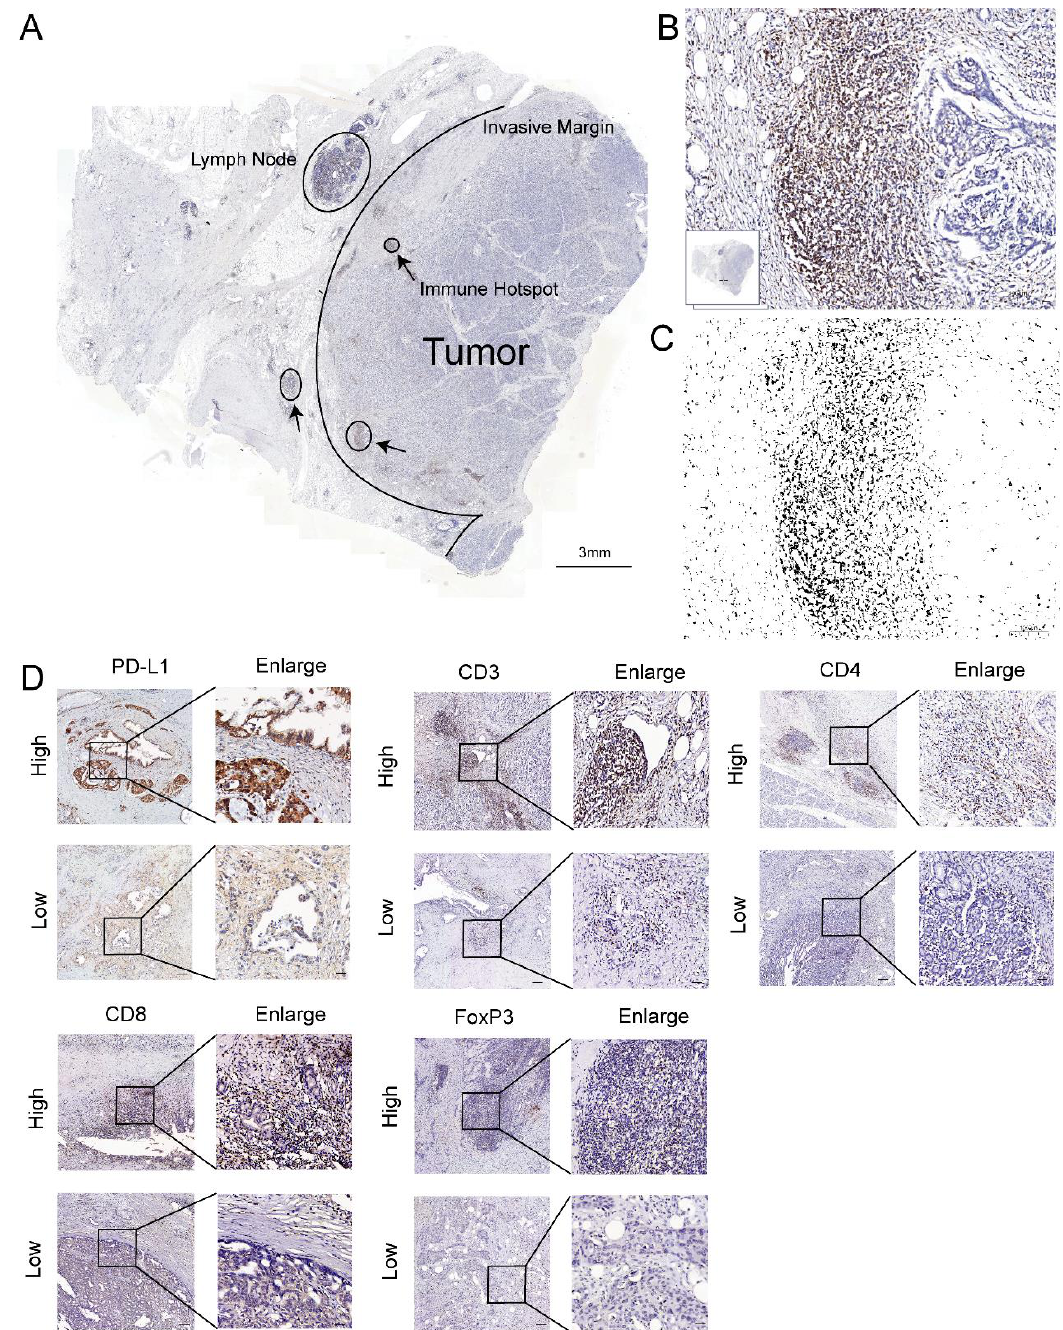
Figure 1. T-cell infiltration marker and PD-L1 in pancreatic cancer. ( A ) Image of a whole section of anti-CD3-stained tissue displaying the regions of tumor and the invasive margin. The immune hotspots are shown with arrows. ( B ) A hotspot in the tumor shows numerous positive T cells and fewer tumor cells. ( C ) The corresponding image analysis shows the counted cells. ( D ) Representative pictures for low and high CD3, CD4, CD8, FoxP3, and PD-L1 immunostaining (brown) in PC tumors. Original magnification, 20 × ; scale bars, 100 µ m. Enlarged images on the right panel are shown for the areas outlined by black squares. Scale bars show 25 µ m in